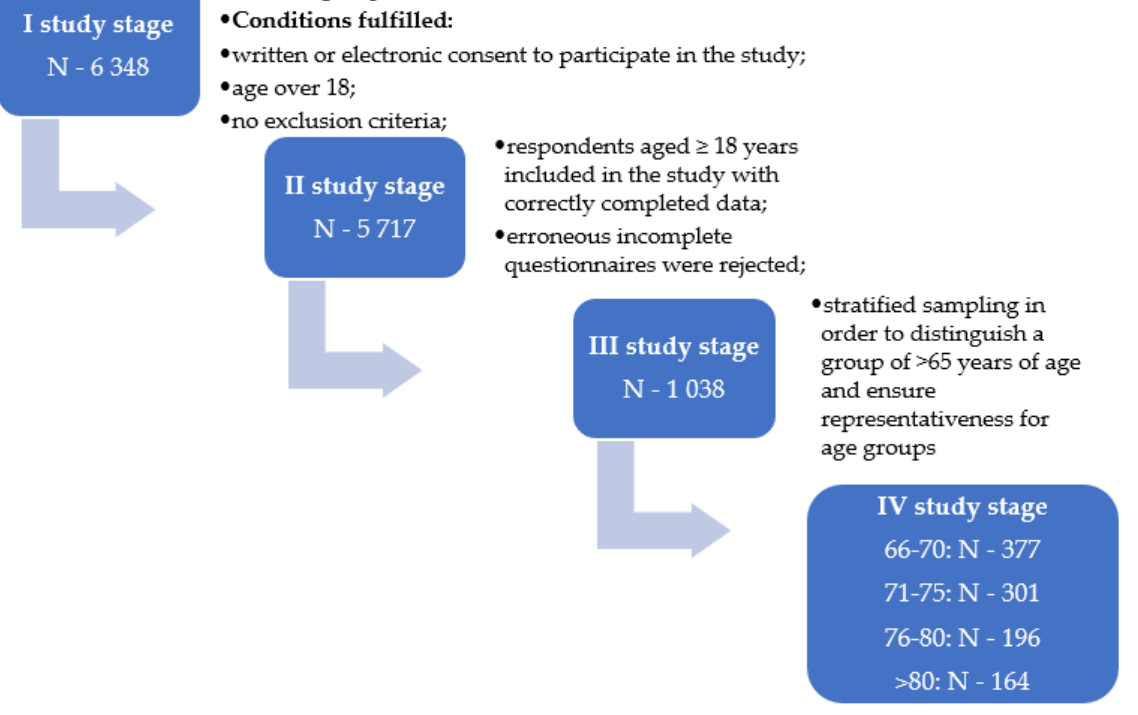
Figure 1. Flowchart of the participant selection process.